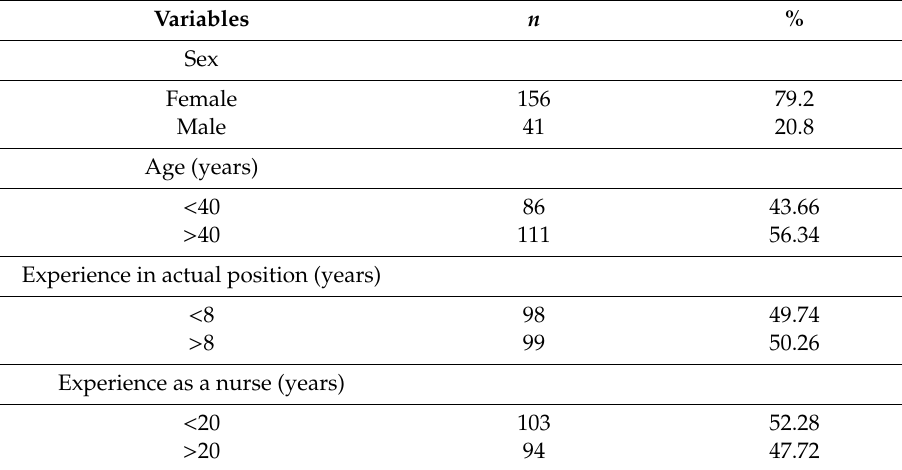
Table 1. Distribution and sample